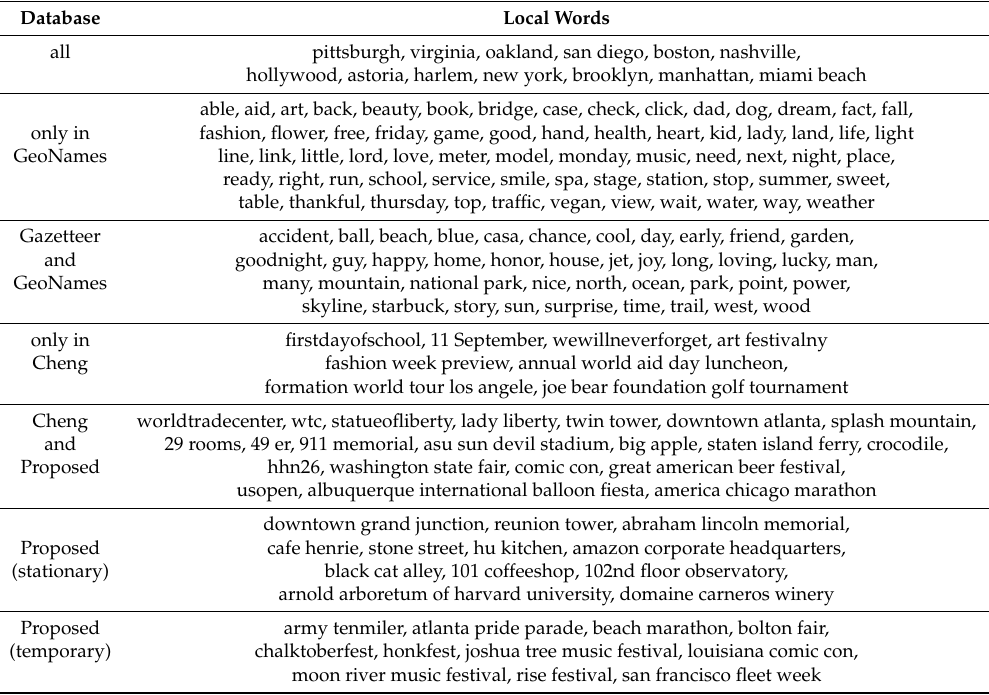
Table 4. Examples of local words in different types of database (Gazetteer, GeoNames, Cheng_30days, and Proposed after 30